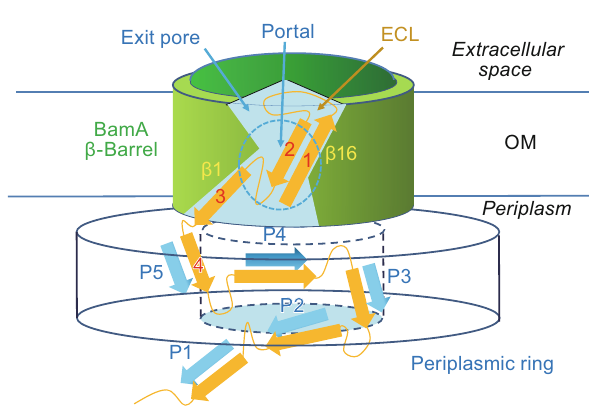
Figure 1. Schematic of the BamA structure. The BamA β -barrel is represented by a green cylinder. The edges of the β -sheets of the fi ve POTRA domains (P1 – P5) are represented by blue arrows. The nascent OMP is orange, and its β -strands are shown as arrows. The N-terminal strand is labeled “ 1 ” , and